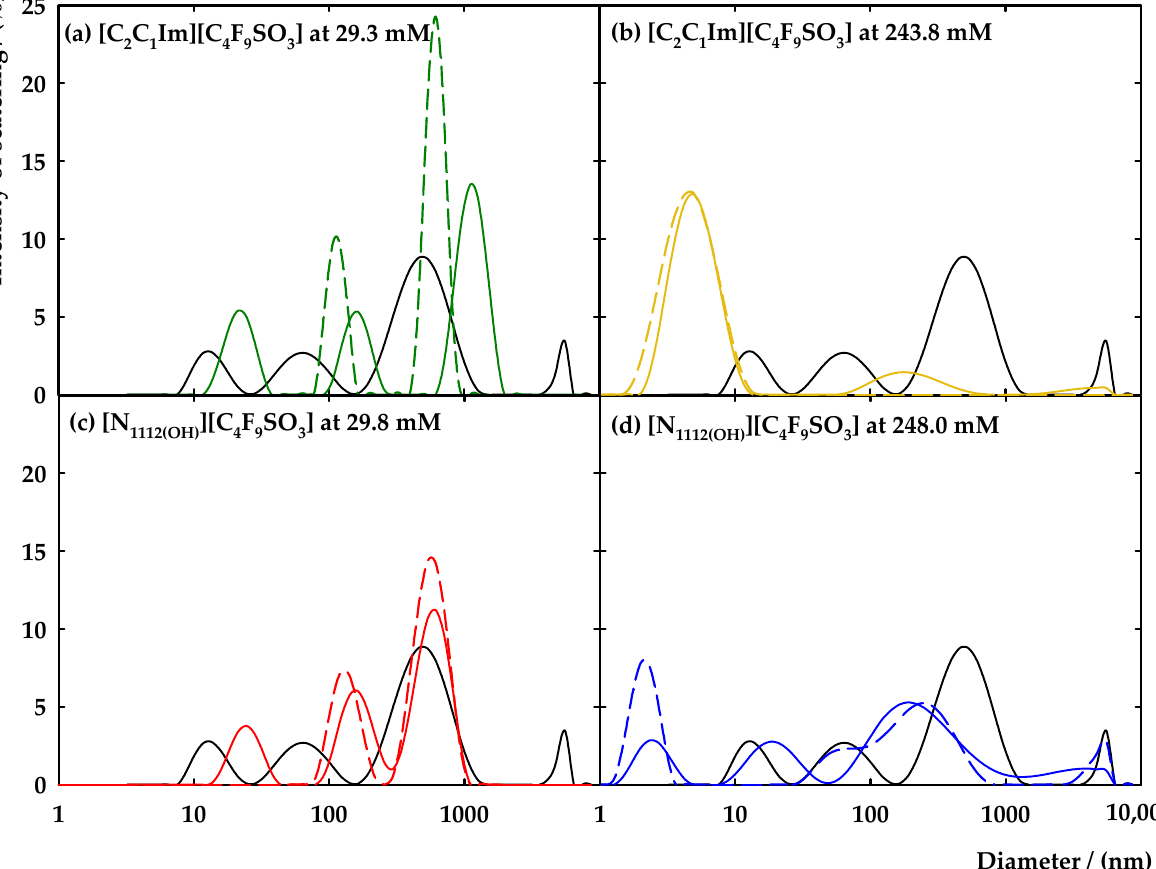
Figure 4. DLS spectra of IFN- α 2b at 50 μ g/mL (black solid line) with [C 2 C 1 Im][C 4 F 9 SO 3 ] at ( a ) 29.3 mM and ( b ) 243.8 mM; and [N 1112(OH) ][C 4 F 9 SO 3 ] at ( c ) 29.8 mM and ( d ) 248.0 mM. Solid lines represent the samples with protein and FIL and the dashed lines illustrate the FILs blanks. All samples were prepared in 150 mM NaH 2 PO 4 at pH = 7.4 and measured at 25 °C.